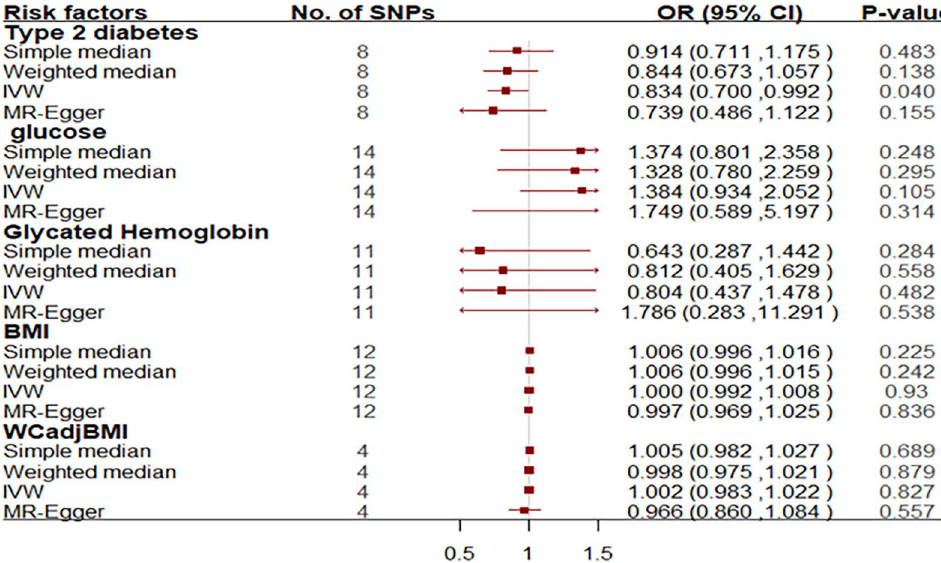
Figure 4. Odds ratio for association between genetically predicted T2D and related traits and ALS in East Asian populations. Squares represent the odds ratio of amyotrophic lateral sclerosis per genetically predicted 1 SD increase in T2D; horizontal lines represent 95% confidence intervals (CIs). SNPs single nucleotide polymorphisms, OR odds ratio, IVW inverse variance weighted, BMI body mass